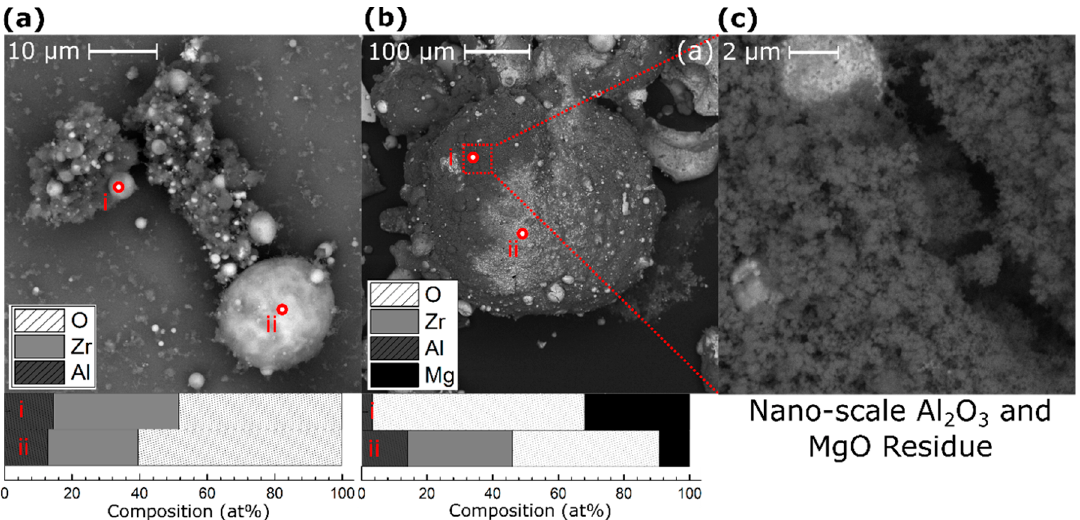
Figure 6. ( a ) Backscatter SEM images of several PVD Al–8Mg:Zr spherical particles collected from the bottom of the calorimeter chamber, outside of the reaction crucible. ( b ) Backscatter SEM image of a sintered Al–38Mg:Zr PVD particle found inside the crucible and the corresponding EDS scans, showing the presence of Mg. ( c ) A zoomed-in view of the intermixed nano-scale Al 2 O 3 and MgO residue coated on the surface of the particles found within the crucible.